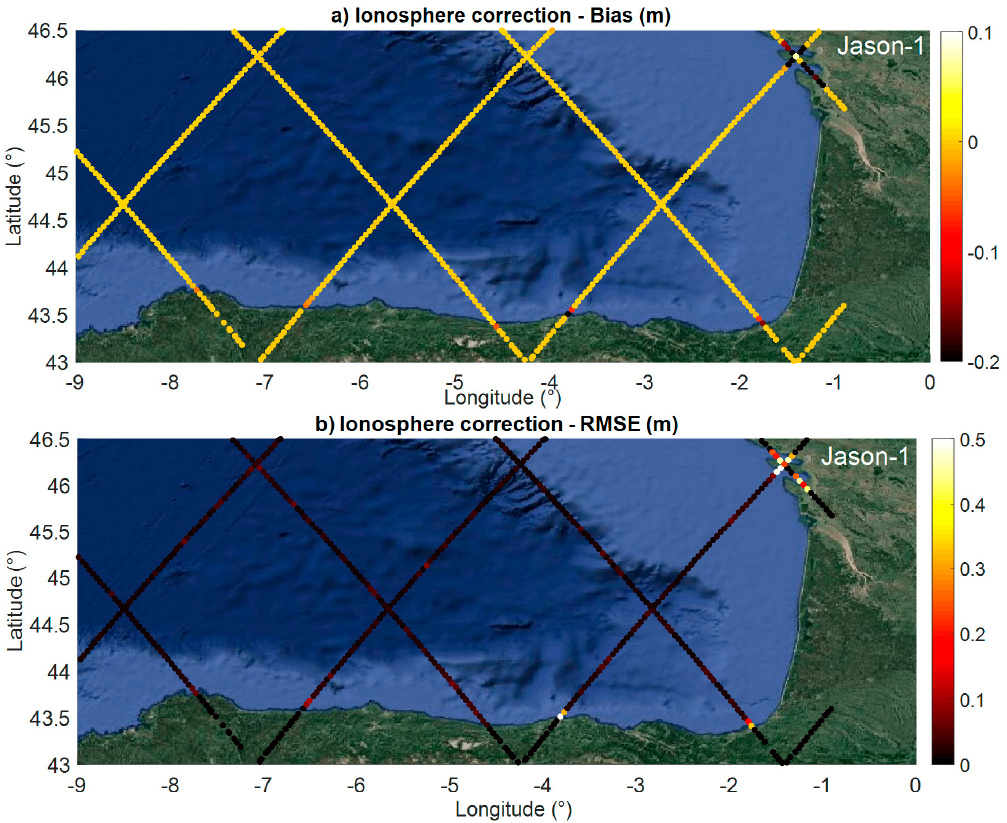
Figure 5. Comparison between ionosphere corrections from bi-frequency measurements and the GIM model for Jason-1: ( a ) bias and ( b )